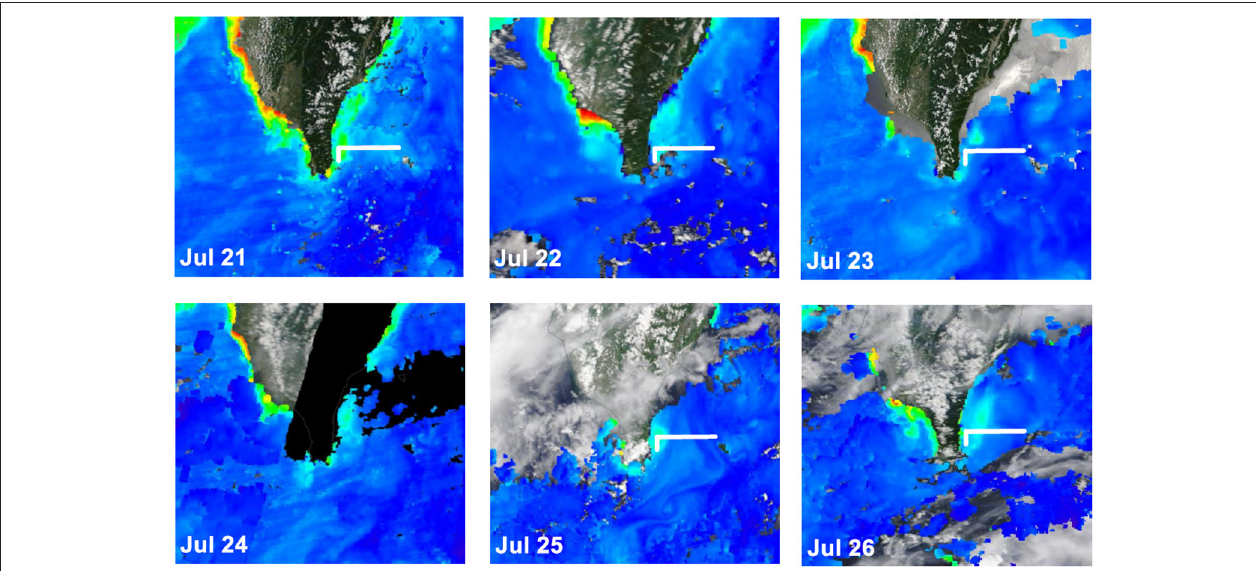
FIGURE 8 | Sequential changes of satellite-derived sea-surface Chl- a concentrations of the investigation period of July 21–25, 2020 (https://oceancolor.gsfc.nasa. gov/). The white line indicates the sampling transect.